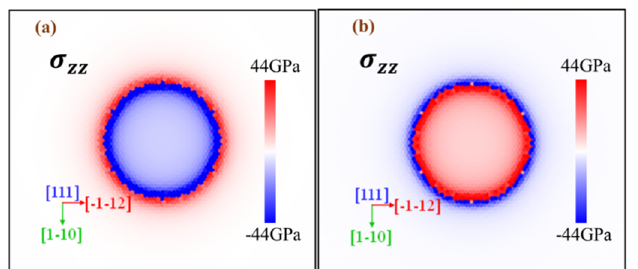
Figure 4. The stress distributions of the ( a ) interstitial dislocation loop and ( b ) vacancy dislocation loop with a radius of 40.0 Å.